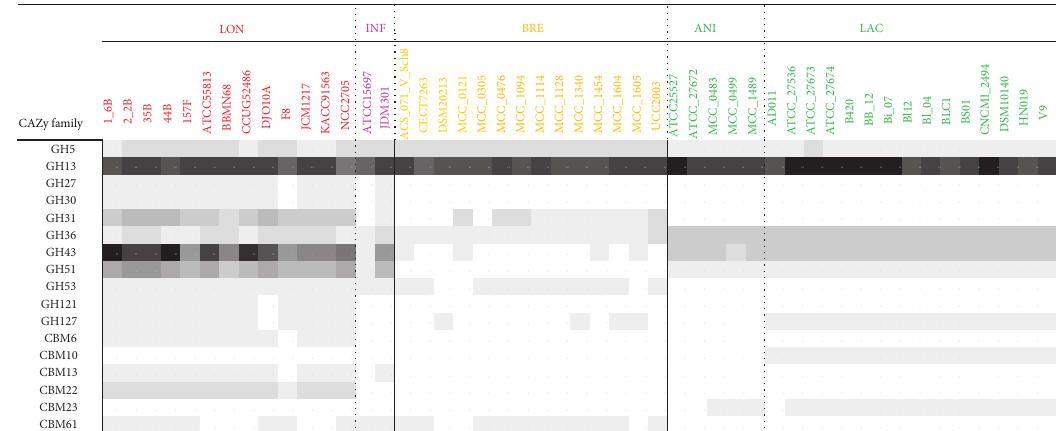
Figure 3: Distribution of genes involved in the metabolism of plant-derived sugars predicted by the CAZy database. The abbreviations used for species/subspecies are as follows: INF, B. longum subsp. infantis ; LON, B. longum subsp. longum ; BRE, B. breve ; ANI, B. animalis subsp. animalis ; LAC, B. animalis subsp.